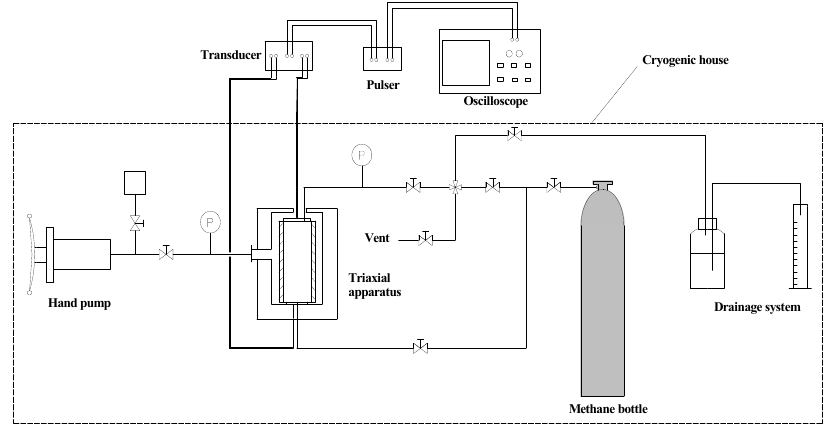
Figure 2. Schematic diagram of the experimental apparatus used to measure P-wave and S-wave velocities of hydrate-bearing